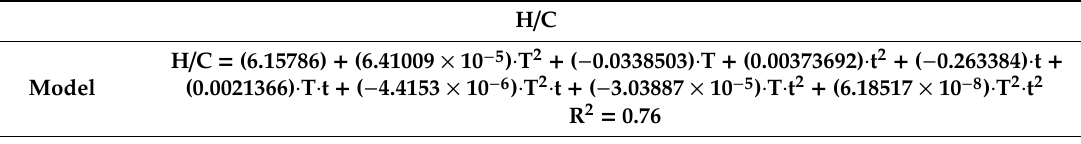
Table A12. The statistical parameters of polynomial regression analysis of the influence of SS torrefaction temperature and residence time on the H / C ratio in biochars.